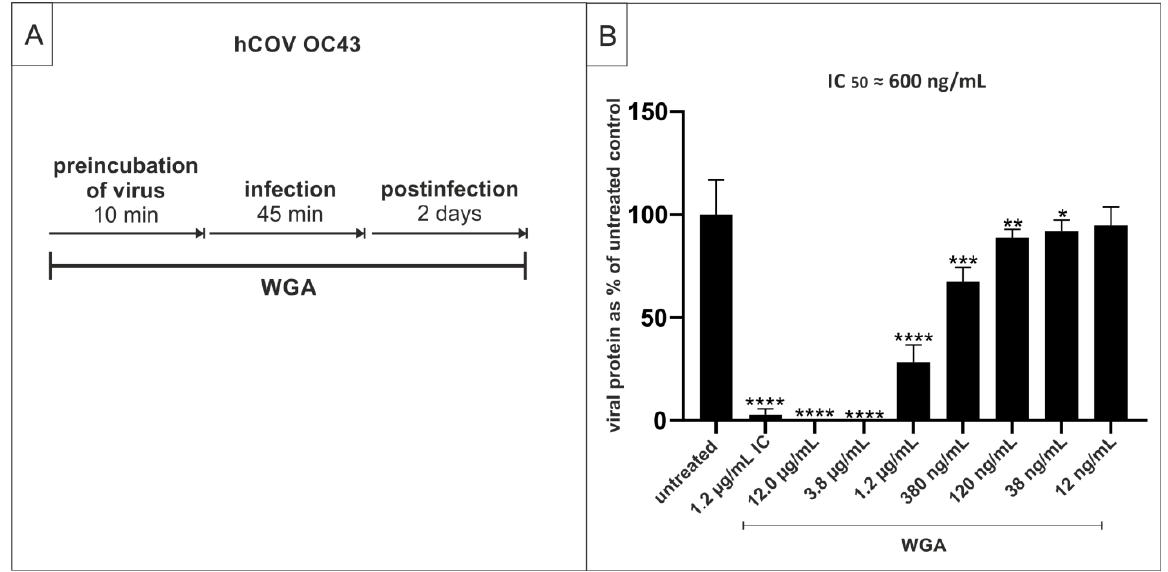
Figure 7. Pre-, co- and post-incubation of endemic hCoV OC43 with WGA blocks infection in Vero cells. ( A ) Treatment scheme. Virus stock was preincubated with WGA and the dilution was then used to infect Vero cells. After infection, the inoculum was removed, and cells were overlaid with medium containing test substance at the same concentrations as in the pre-/co-incubation treatment. ( B ) Quantification of viral NP in fixed cells after pre-, co-, and post-infection treatment with WGA. Iota-carrageenan (IC) at 1.2 µg/mL was added as control. The graphs show viral protein as percent of the untreated control and standard deviation of quintuplets. * p ≤ 0.05, ** p < 0.005, *** p < 0.0009 and **** p < 0.0001 using a one-sample t-test.